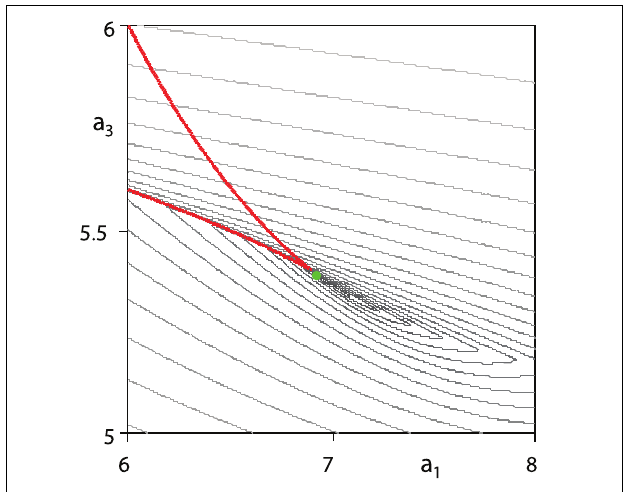
FIGURE 8 | The gray curves show the contour plot (decrement diagram) of the abscissa a of the polynomial (5) when a 2 is restricted to 10. The green circle at the cusp of the red discriminant curve (17) marks the location of the EP 3 singularity, where the abscissa reaches its minimum in this case.